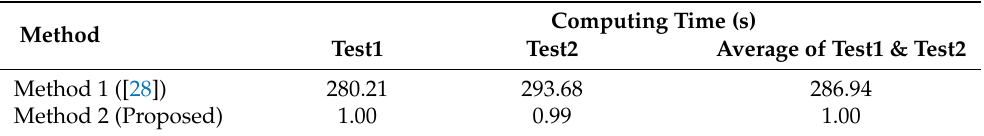
different weight factors. ::::::: :::::: ::::::